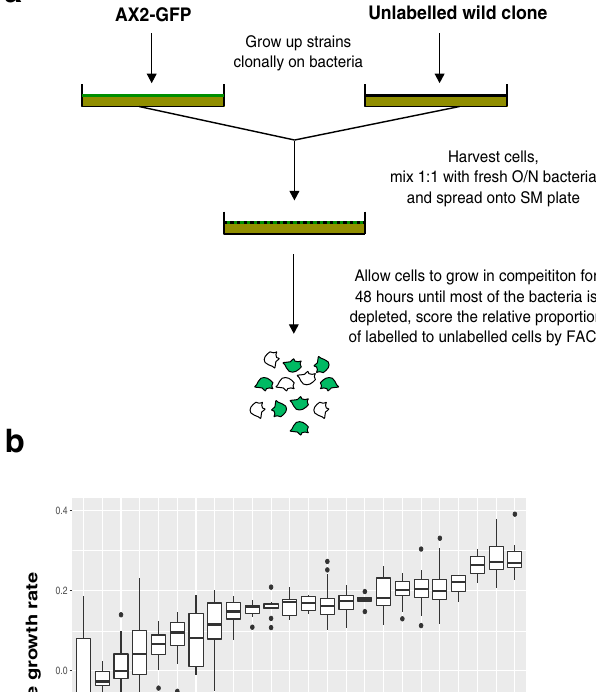
F 23 = 20, p < 2×10 − 16 ) (Fig. 1b), with >2.5 fold difference in relative growth between the strains showing the highest (NC69.1) and lowest (NC39.1) growth rates. To ensure that these differ- ences accurately re fl ect variation in predatory ef fi ciency of the strains (rather than interference competition with the standard competitor), the clonal growth rates of six different genotypes (representing examples from the top, middle and bottom of the growth hierarchy) were measured. Cells of each strain were plated clonally with K. aerogenes and the total number of cells counted following 48 h of growth (Supplementary Fig. 1A). Estimates of clonal growth are signi fi cantly correlated with competitive per- formance against AX2-GFP ( r = 0.98, p < 0.001, Supplementary Fig. 1B), which supports the conclusion that D. discoideum strains exhibit differences in vegetative growth rate, and that these are driven by resource competition rather than interference competition. Swaps in predatory performance of D. discoideum strains on alternative prey . D. discoideum amoebae encounter diverse bac- terial prey in nature 38 . We, therefore, tested whether growth on K. aerogenes re fl ects growth on other prey, or whether differences in predatory success across different prey species could potentially facilitate the maintenance of variation. The relative growth rates of eight representative D. discoideum strains from the analysis of growth on K. aerogenes were measured on a panel of six different bacterial species from diverse phyla, including proteobacteria, actinobacteria and fi rmicutes. These species were chosen to capture a representative spectrum of the different types of bacteria that have been co-isolated with D. discoideum and can be used as a growth resource 35,39 . This set includes four Gram-negative [Gram( − )] species ( K. aerogenes, Klebsiella pneumoniae, Escherichia coli and Pseudomonas aeruginosa ) and two Gram-positive [Gram( + )] bac- terial prey species ( Bacillus subtilis and Micrococcus luteus ). This panel allows us to capture variation in predator performance